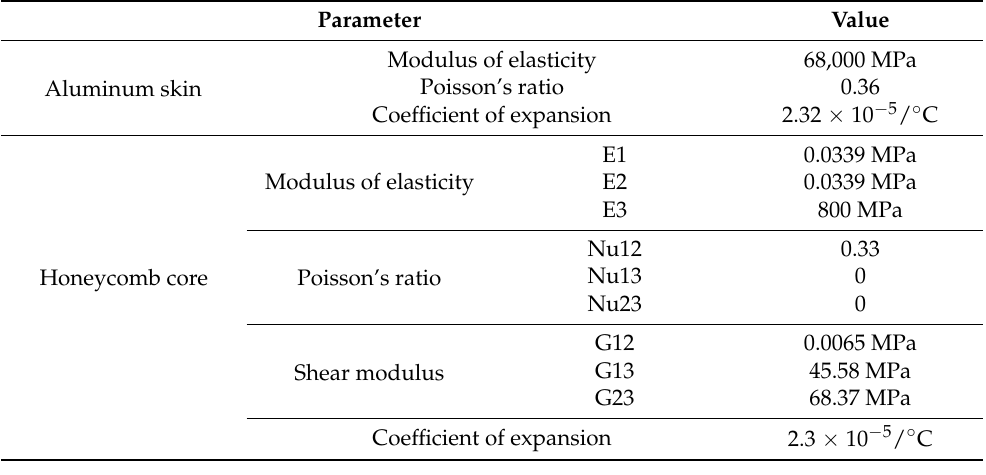
Table 2. Model’s initial material parameters.